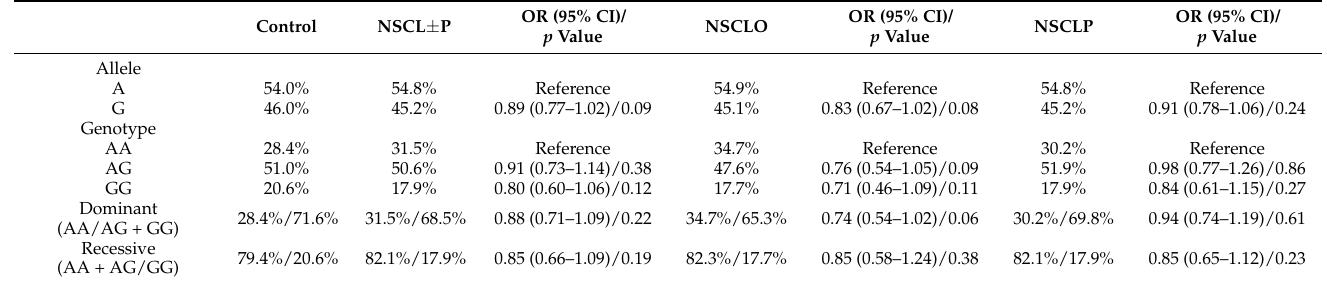
Table 3. Association between CASP8 rs3769825 and the risk of nonsyndromic cleft lip with or without cleft palate (NSCL ± P), nonsyndromic cleft lip only (NSCLO) and nonsyndromic cleft lip and palate (NSCLP). p values were adjusted for covariates by logistic regression analysis.